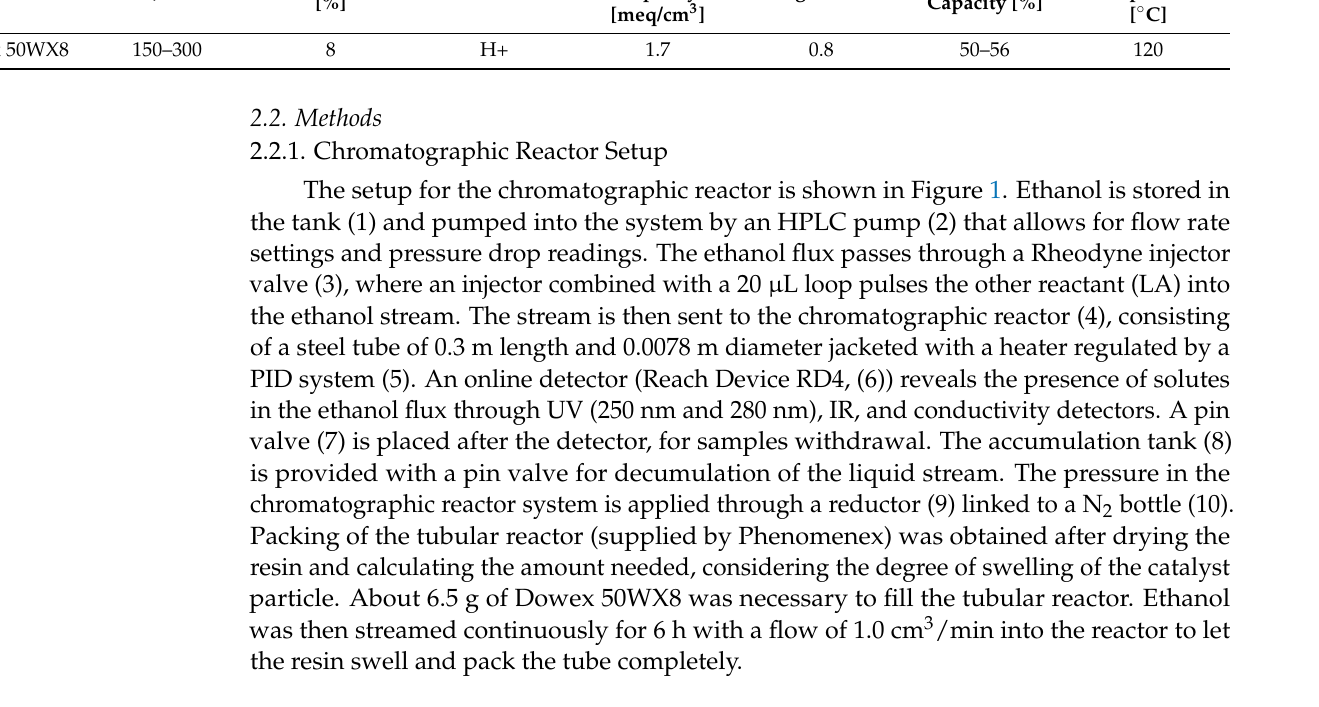
Table 1. Physical properties of the used Dowex 50WX-8 catalyst.